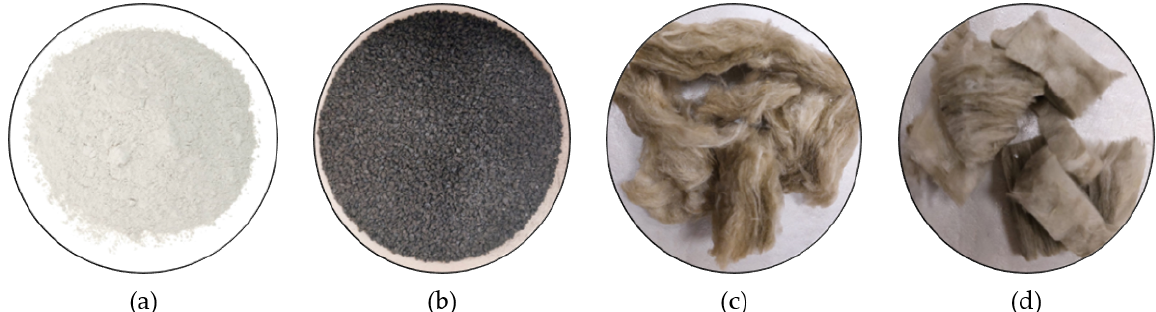
Figure 1. Raw materials used: ( a ) fine gypsum; ( b ) granular end-of-life tyre particles; ( c ) recycled rock wool fibre; and ( d ) recycled glass wool fibre.